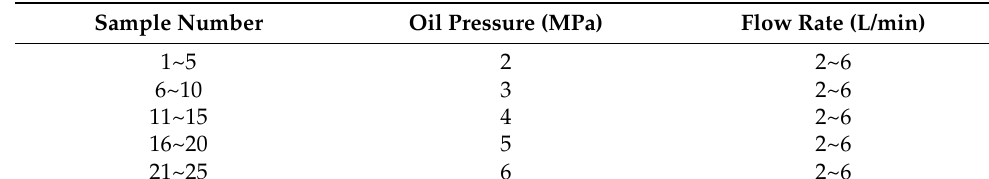
Table 2. The meanings of sample data numbers in Figure 6.